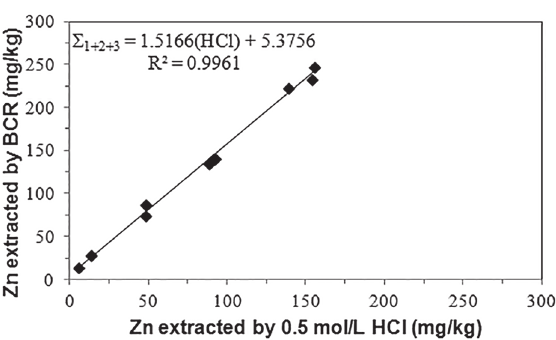
Fig. 3. Correlation between the Zn concentration extracted from sediment samples with 0.5 mol/L HCl, and the sum of three labile phases extracted by sequential extraction procedure BCR (n =